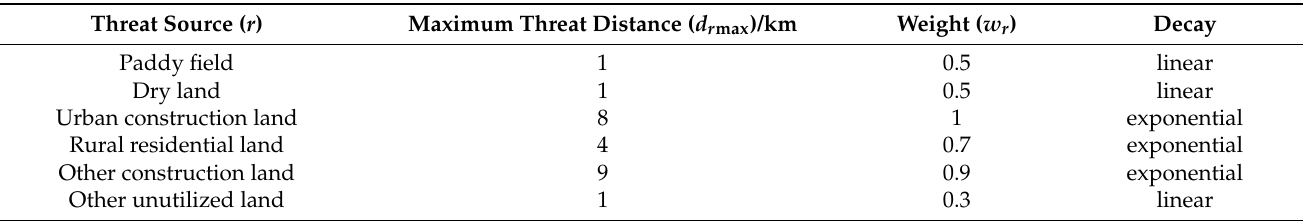
Table 1. Maximum impact distances, weights, and spatial recession types of threat